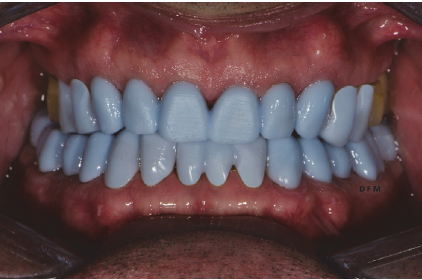
Figure 3: Clinical evaluation of the aesthetic and functional out- come of the provisional.